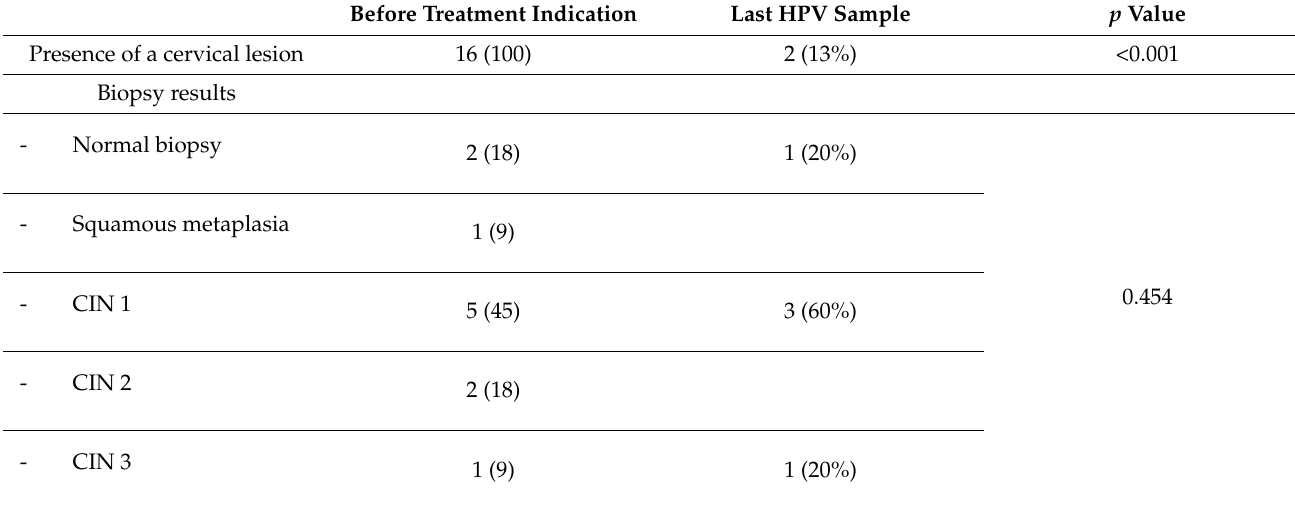
Table A2. Prevalence of cervical lesions, biopsy results, and pap smear results at the time of treatment indication and by the end of the follow-up among women who did not receive